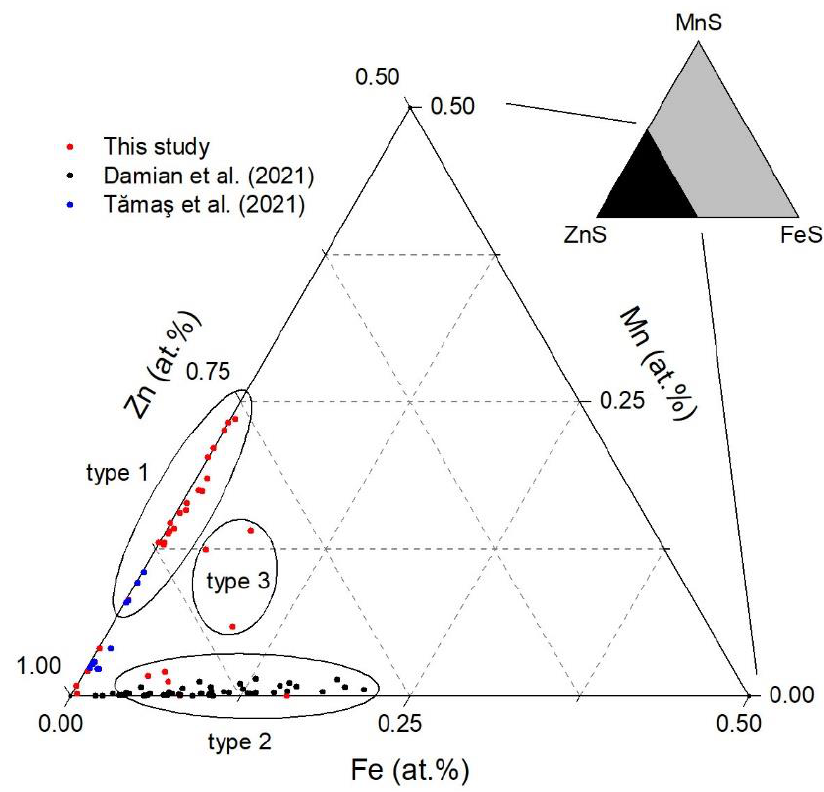
Figure 8. Zn – Mn – Fe ternary diagram showing the chemistry (expressed in at.%) of the main genetic types of sphalerites from three epithermal ore deposits from Romania: Săcărâmb (this study ), Baia Mare area [40], and Ro¸sia Montan ă Mare area [40] , and Roşia Montană [39] .